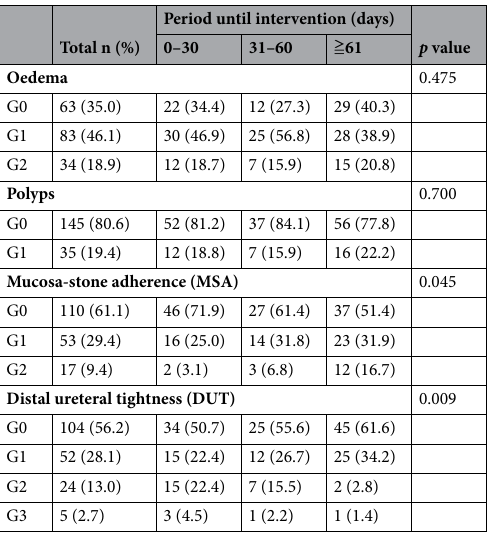
Table 3. Association between endoscopic findings and period until